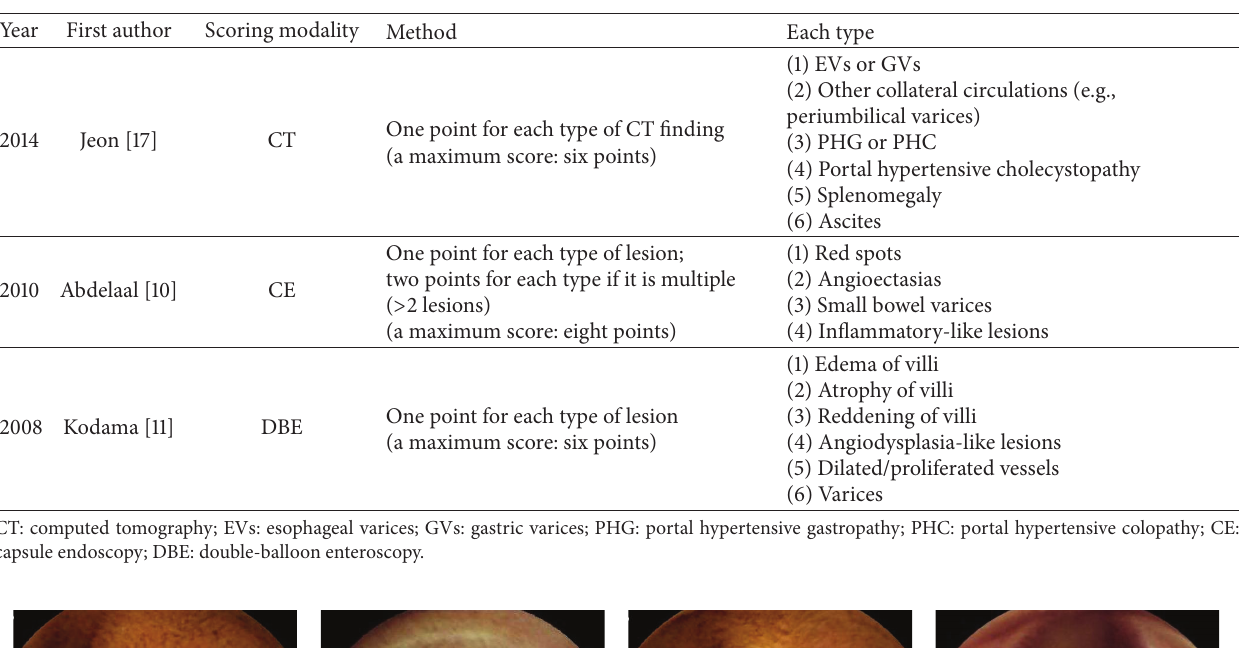
Table 3: Currently available scoring systems using various modalities.